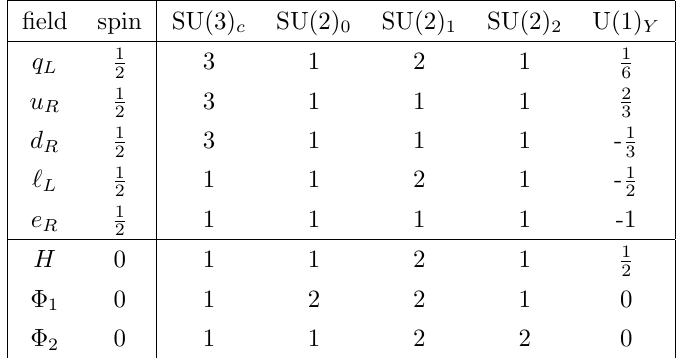
Table 1 . The matter and Higgs (cid:12)elds and their gauge charges in the model. The generation indices for the matter (cid:12)elds are